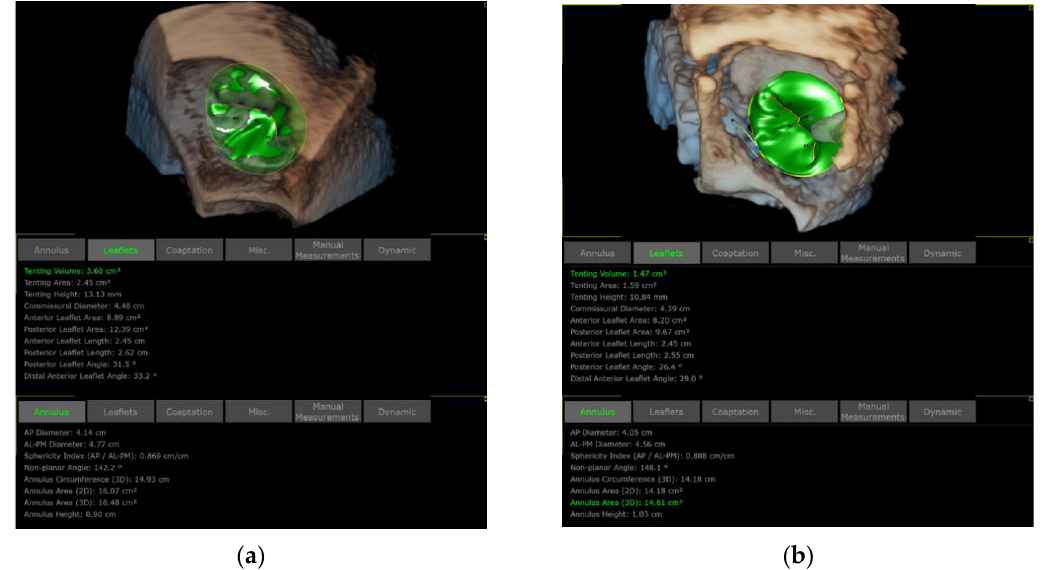
Figure 12. Comparison of TA and TV dimensions before and after K-Clip ™ implantation. ( a ): TA and TV measurements before annuloplasty; ( b ): TA and TV measurements after intervention.